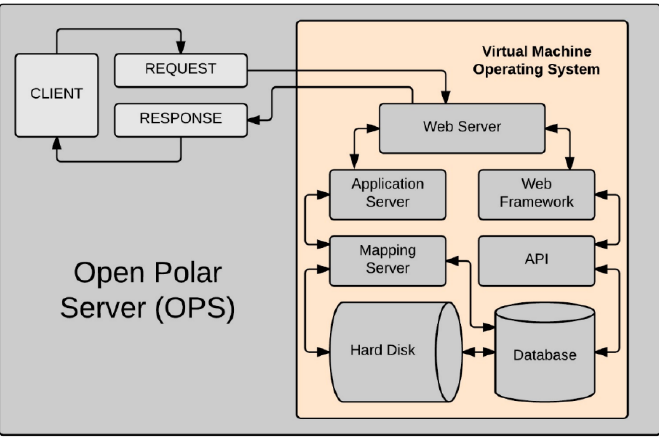
Figure 3. A conceptual diagram of the Open Polar Server (OPS) infrastructure components.